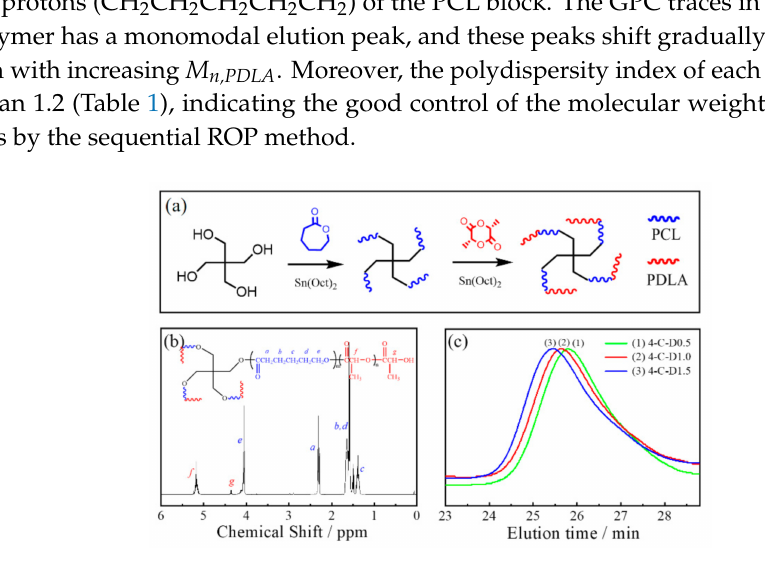
Figure 1. Synthesis of the 4-C-D copolymers with di ff erent M n,PDLA s. ( a ) Synthesis scheme, ( b ) 1 H NMR spectrum, and ( c ) GPC curves. Table 1. Characteristics of PLLA and 4-C-D copolymers with di ff erent M n,PDLA